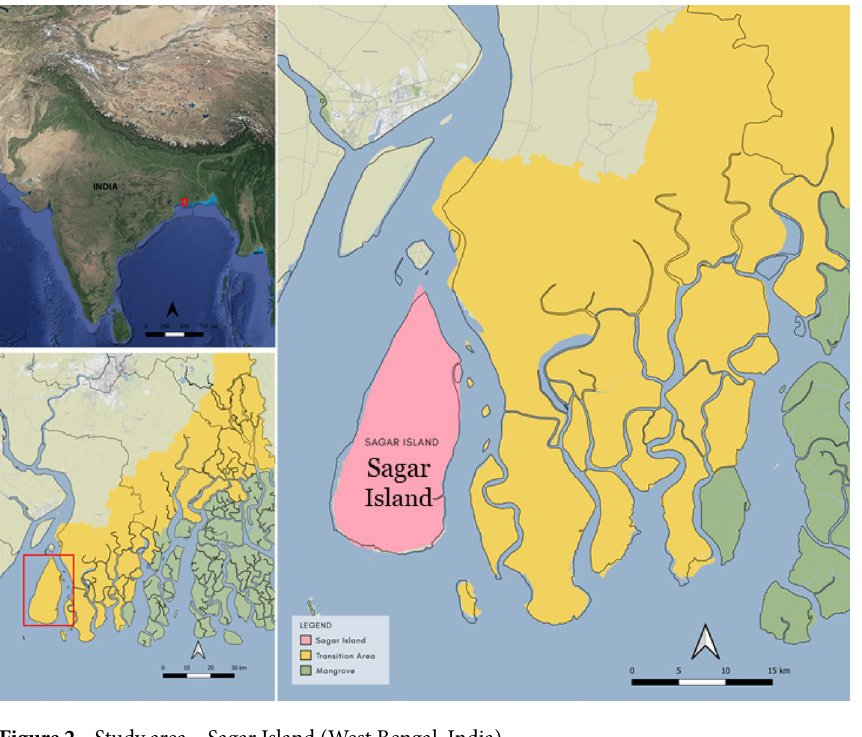
Figure 2. Study area—Sagar Island (West Bengal, India).